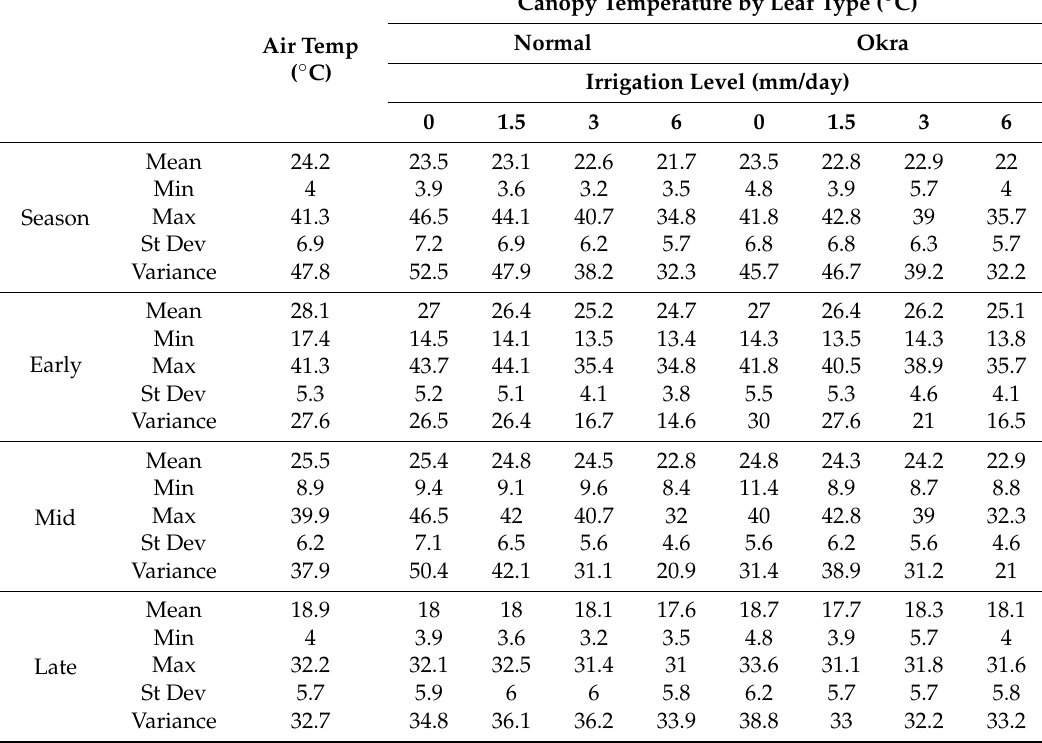
Table 1. Canopy temperature statistics for okra and normal leaf varieties across seasonal periods at four irrigation